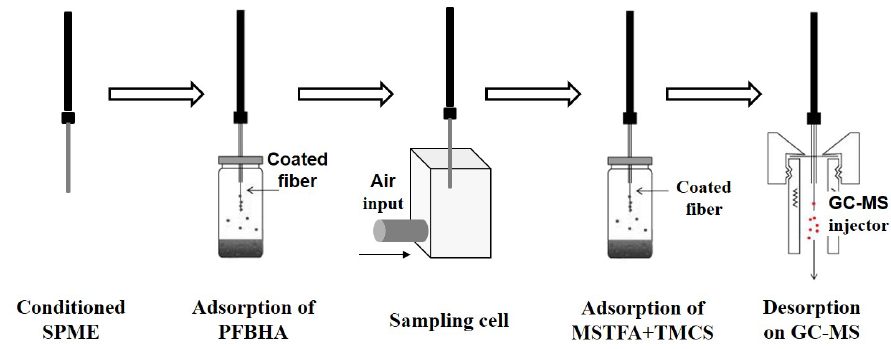
Figure 1. Scheme of sampling and on-fibre derivatization